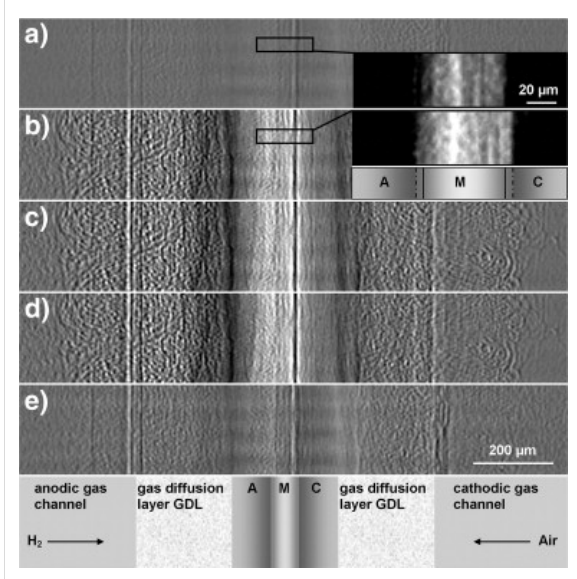
Figure 14: Normalized radiographs of the cross section of the MEA at different current densities j : a) 0 mA·cm − 2 (OCV before), b) 140 mA·cm − 2 , c) 300 mA·cm − 2 , d) 550 mA·cm − 2 and e) 0 mA·cm − 2 (OCV after). Inset: Non-normalized enlarged radiographs of the membrane and parts of the catalyst layers at OCV and j = 140 mA·cm − 2 (A, anode; M, membrane; C, cathode). Reprinted with permission from [65]. Copyright 2010 Elsevier.